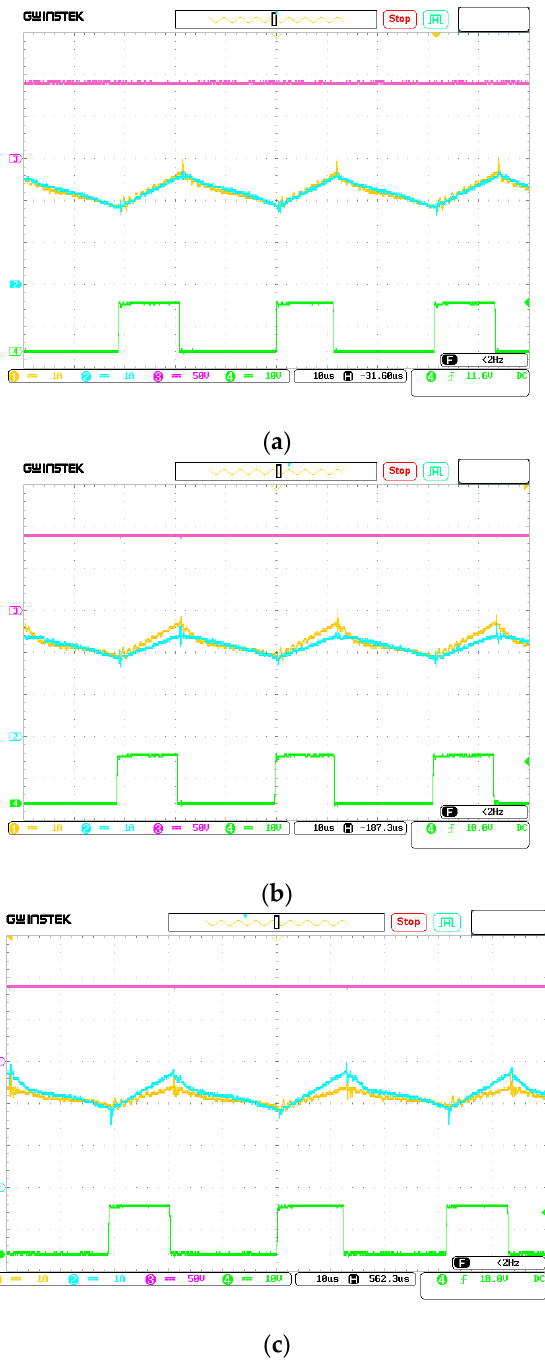
Figure 8. Experimental results for v 0 (Top: 50 V/div, Pink), i L 1 (Middle: 1 A/div, Yellow), i L 2 (Middle: 1 A/div, Blue) and v d (Bottom: 10 V/div, Green) for the average current mode controlled proposed step-up converter under three cases. ( a ) Case 1: L 1 = 1.2 mH and L 2 = 1.2 mH; ( b ) Case 2: L 1 = 1.2 mH and L 2 = 2.27 mH; ( c ) Case 3: L 1 = 2.27 mH and L 2 = 1.2 mH.